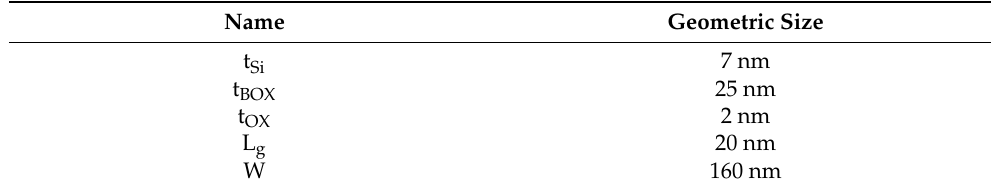
Table 1. The main dimensions of the 22-nm FDSOI MOSFET.